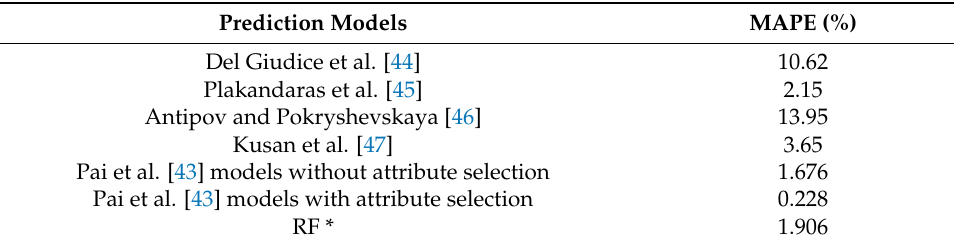
Table 10. A list of MAPE values of previous studies and this study. Prediction